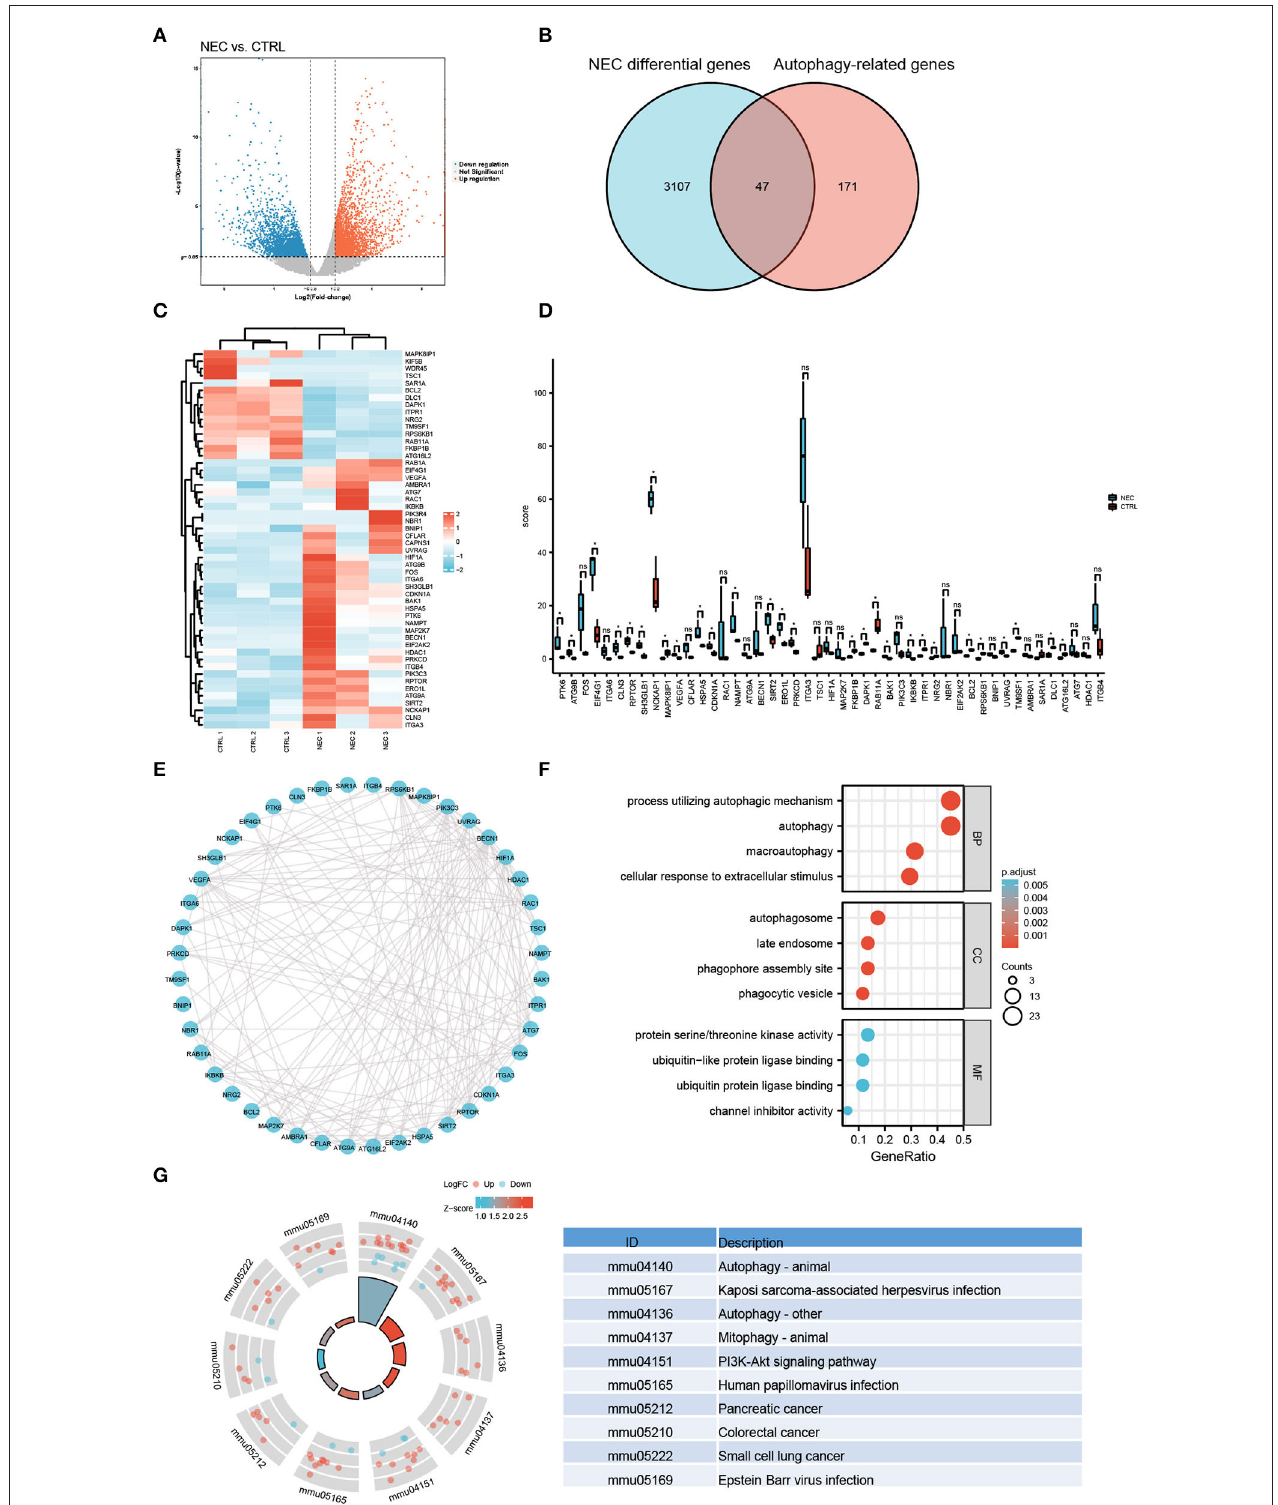
FIGURE 2 | Autophagy-related differentially expressed genes (arDEGs) autophagy-related genes in our neonatal mouse model of NEC. (A) Volcano plot of the differentially expressed genes (DEGs) in the NEC group. The red dots represent the significantly upregulated genes while the blue dots represent the significantly downregulated genes. (B) Venn image of arDEGs in NEC. (C) A heatmap of the 47 arDEGs in NEC and CTRL mice. (D) The boxplot of 47 arDEGs in NEC and CTRL groups. (E) The protein–protein interaction (PPI) analysis of the 47 arDEGs. (F) Gene Ontology (GO) enrichment analysis of 47 arDEGs. (G) Kyoto Encyclopedia of Genes and Genomes (KEGG) enrichment signaling pathway analysis of 47